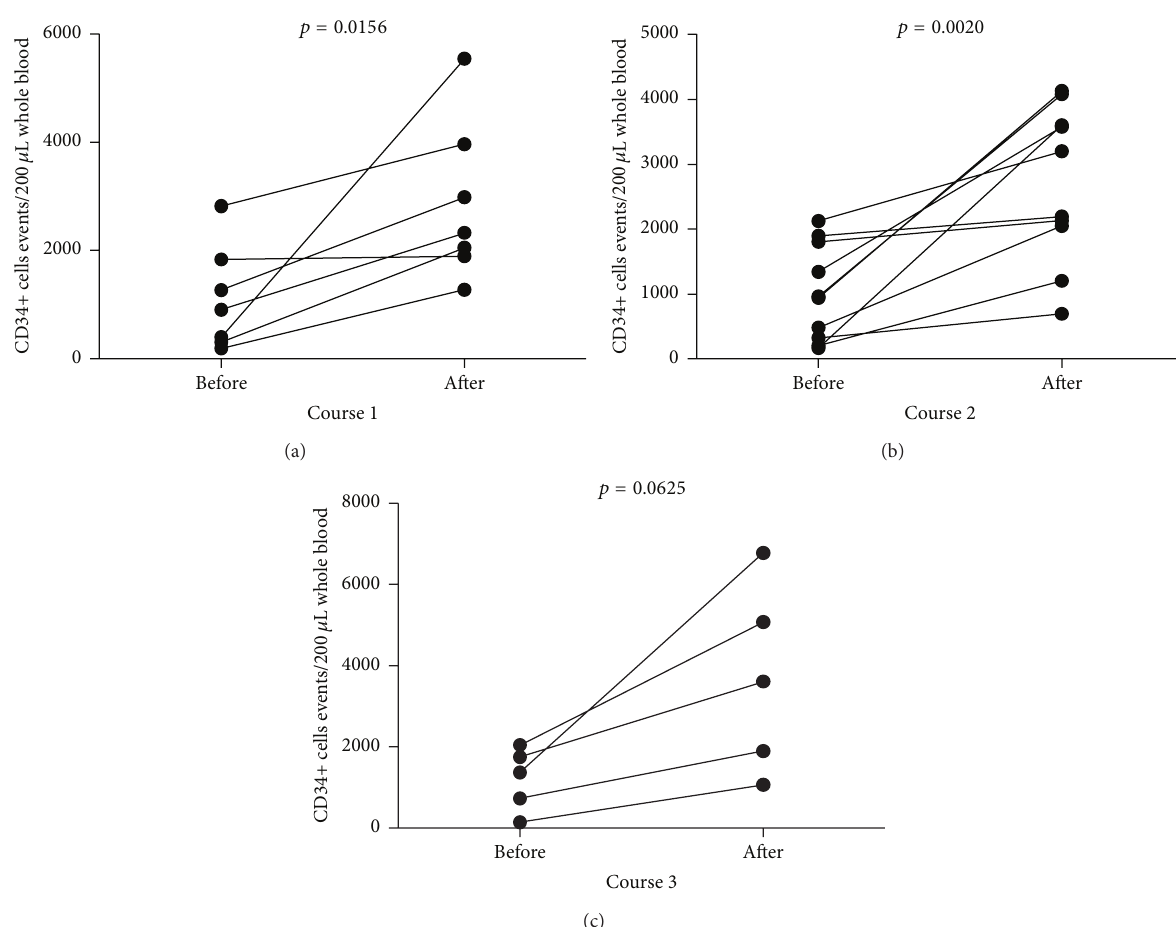
Figure1:ThesummaryofanalysesofchangesinCD34+cellsnumbersafter(a)course1,(b)course2,and(c)course3ofG-CSFadministration in MD pediatric